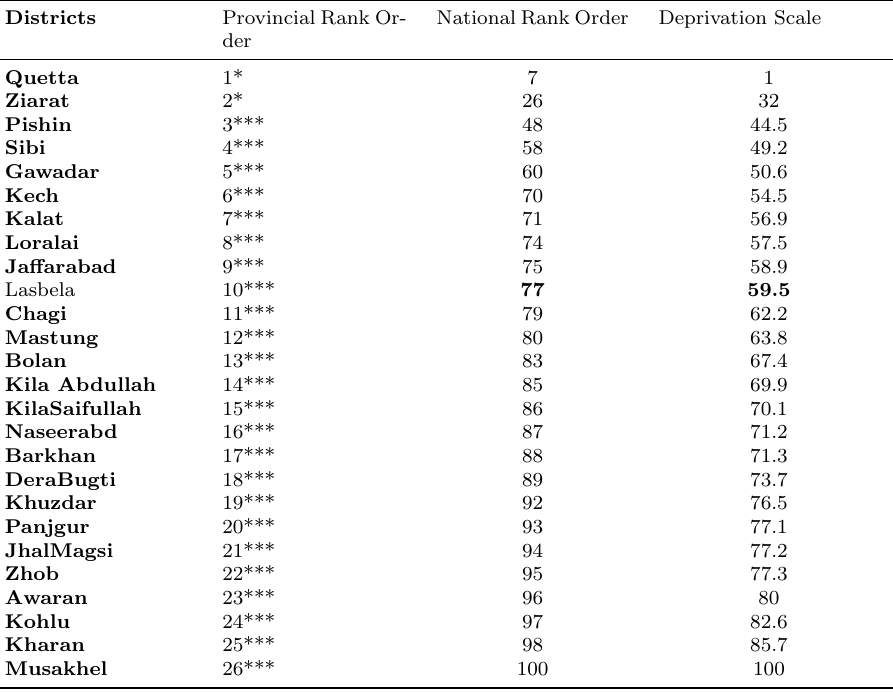
Table 1: Multidimensional Deprivation ranking of districts Balochistan Districts Provincial Rank Or- der